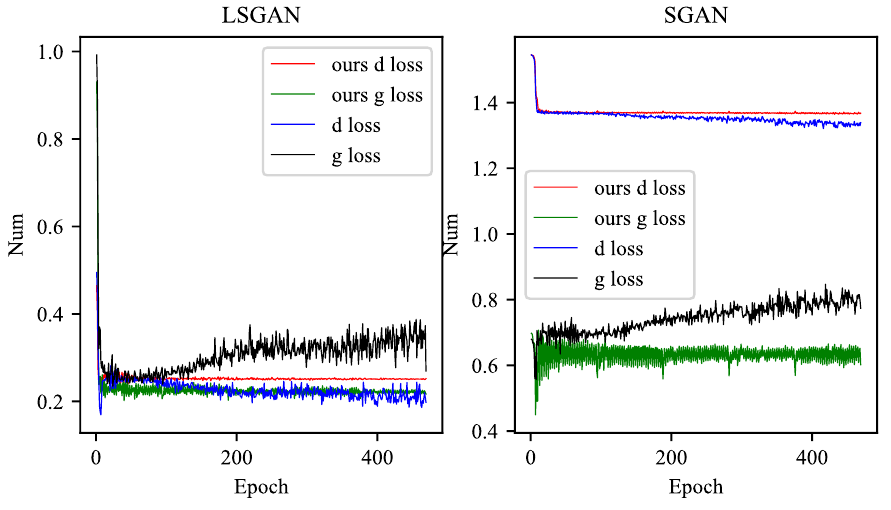
Figure A3. The results of the LSGAN [9] and SGAN [17]